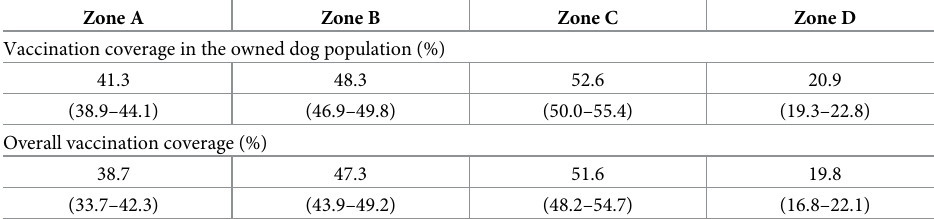
Table 4. Estimated vaccination coverage in owned and overall dog populations through the first mass vaccination campaign. Zone A Zone B Zone C